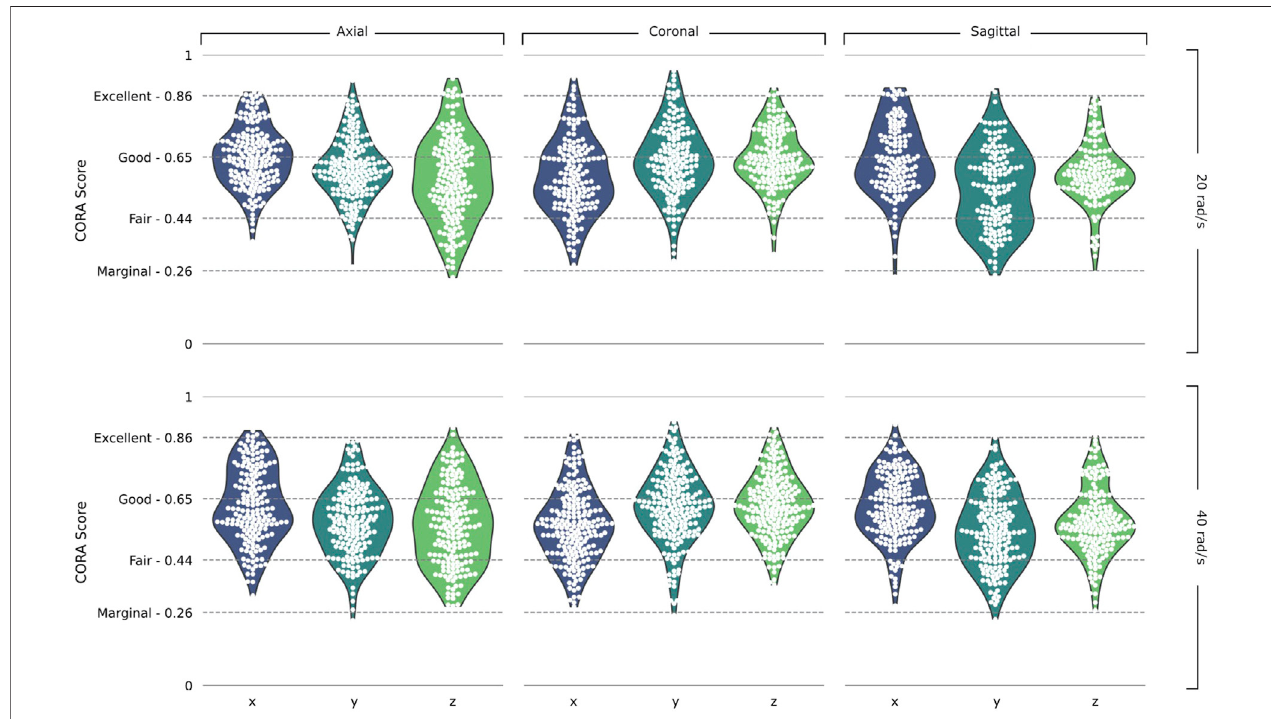
FIGURE 4 | Validation results. Violin plots of CORA scores in the Axial, Coronal, and Sagittal planes and the 20 rad/s and 40 rad/s rotational velocity simulations, split into the x, y, and z components of the head axes. ISO/TR 9790 bio fi delity ratings are shown on the vertical axis.